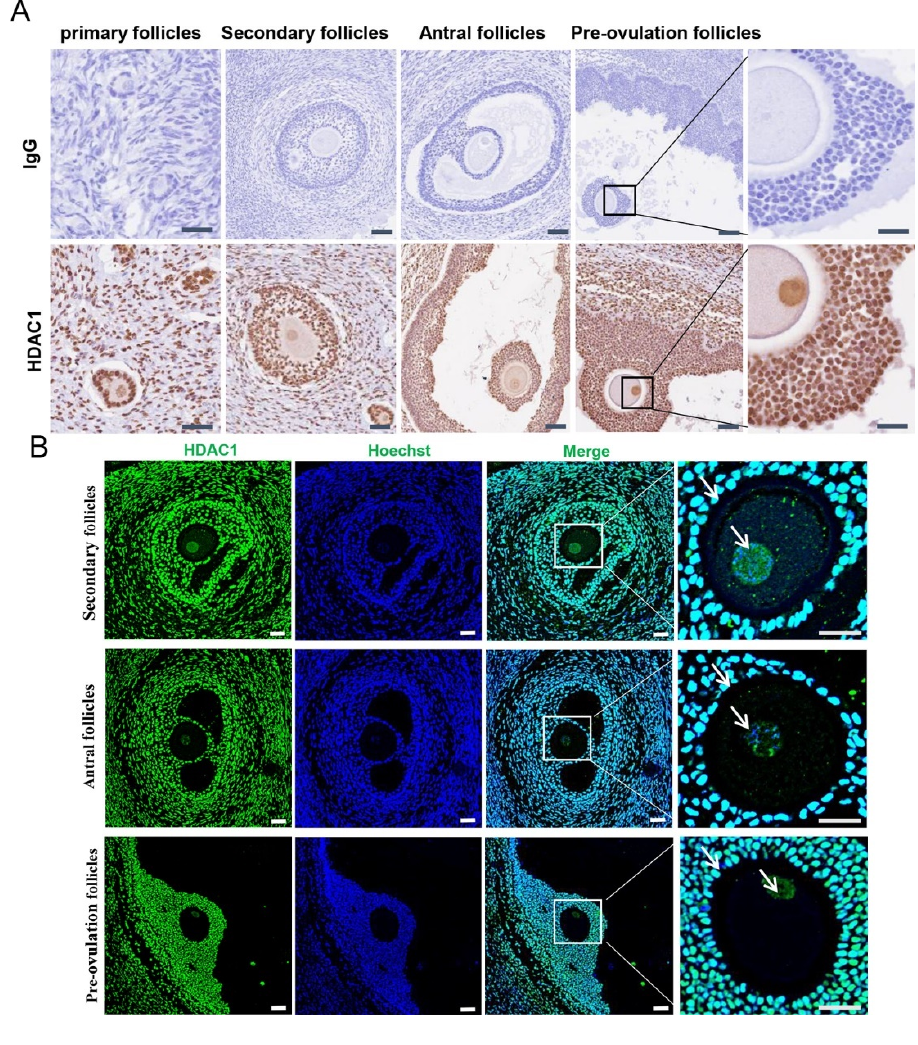
Figure 1. Localization and expression pattern of HDAC1 in the ovary of Tan sheep. ( A ) Immuno- histochemistry. The scale was 200 μ m. The image in the far-right column is a magnified view of the pre-ovulation follicle. ( B ) Immunofluorescence. Note: Green fluorescence indicates HDAC1, and blue fluorescence indicates Hoechst staining to mark the nucleus. The scale was 200 μ m; the rightmost column contains an enlarged view of the merged picture.